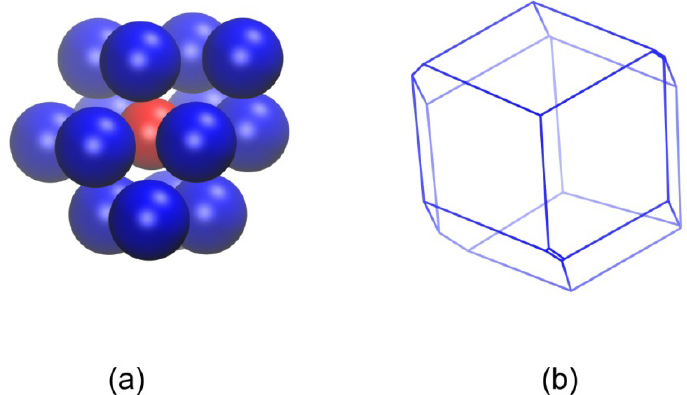
Figure 11. Same as in Figure 9 but for a reference hard sphere with well-ordered fcc-like local structure ( ). Global shape measures for the Voronoi cell: asphericity and relative shape anisotropy